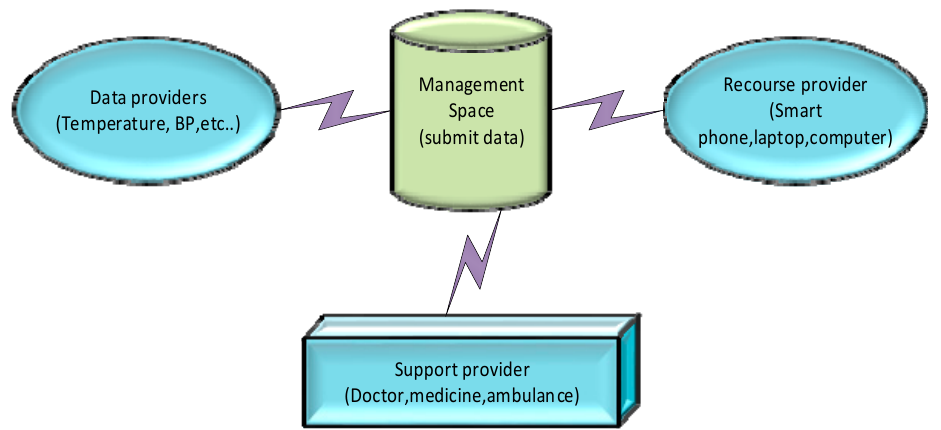
Figure 4. Health care solution using IoT.